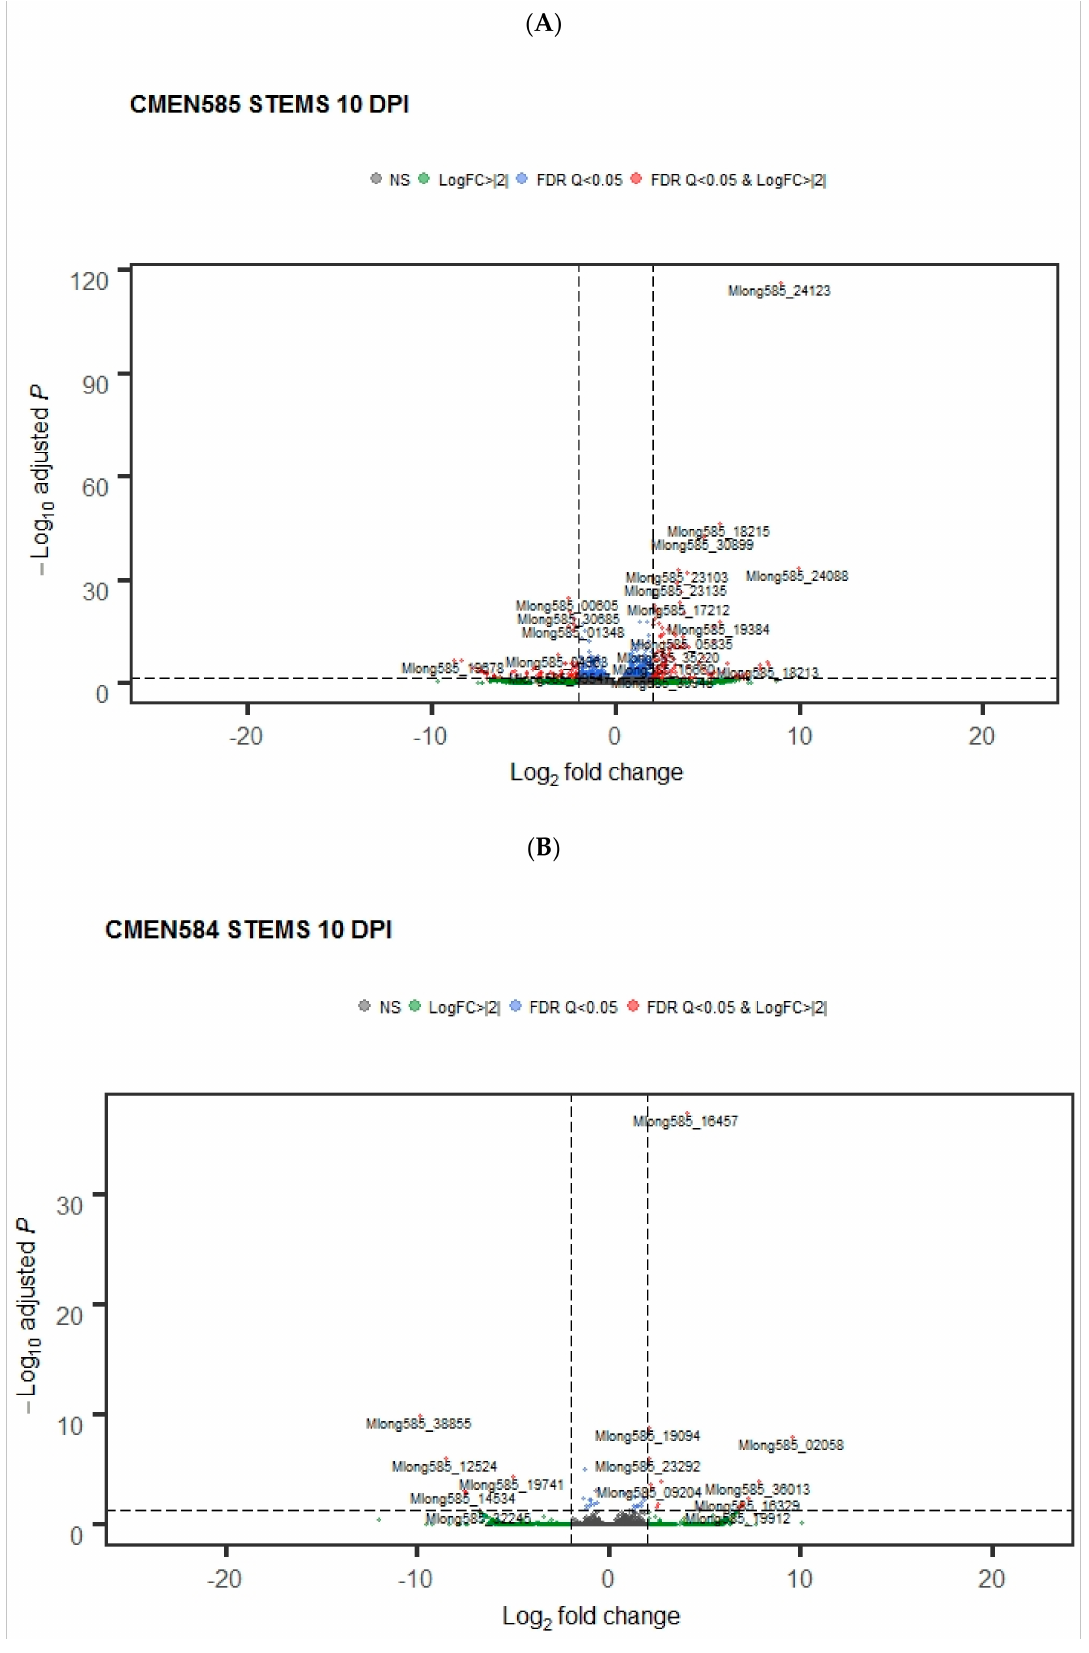
Figure 6. Volcano plots showing differentially expressed gene profiles in stems of ( A ) CMEN585 and ( B ) CMEN584 at 10 and 20 days